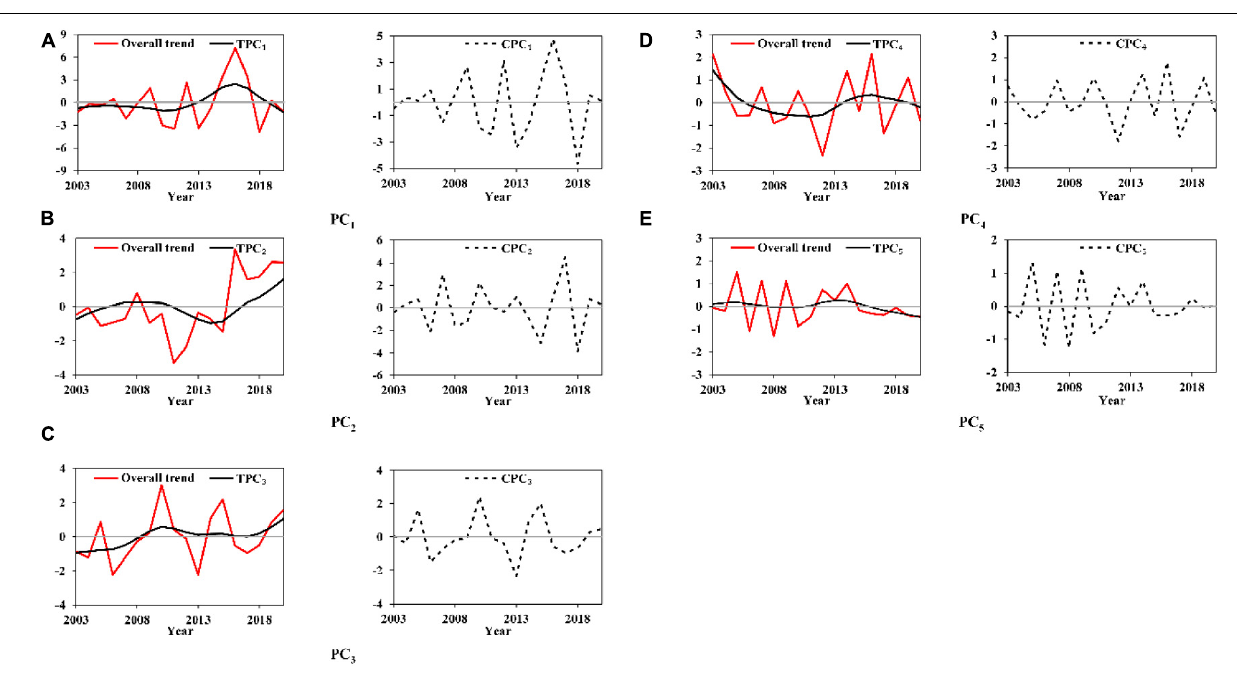
increasing in 2003 ∼ 2007 and decreasing after 2011 ( Figure 6B